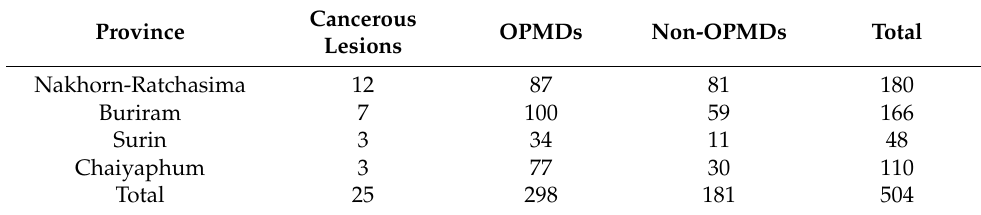
Table 3. Results of biopsies (number of lesions).